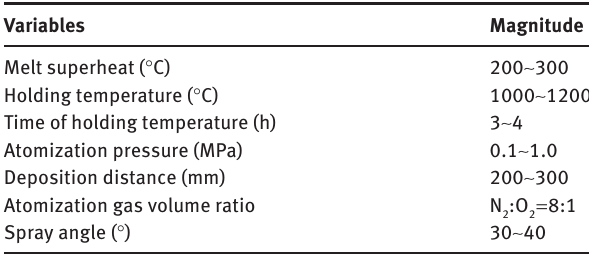
Table 1 Parameters of spray deposition forming.